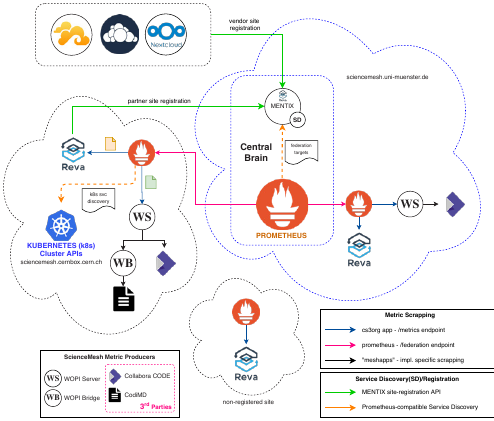
Figure 5. ScienceMesh Federated Monitoring